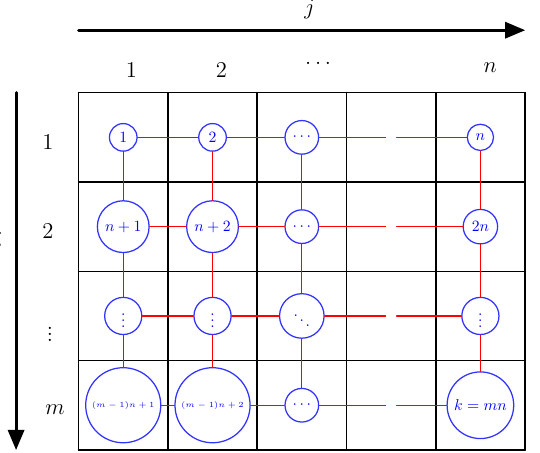
Figure 3. The indices, initial labels of area units, and the representation of graph G M are